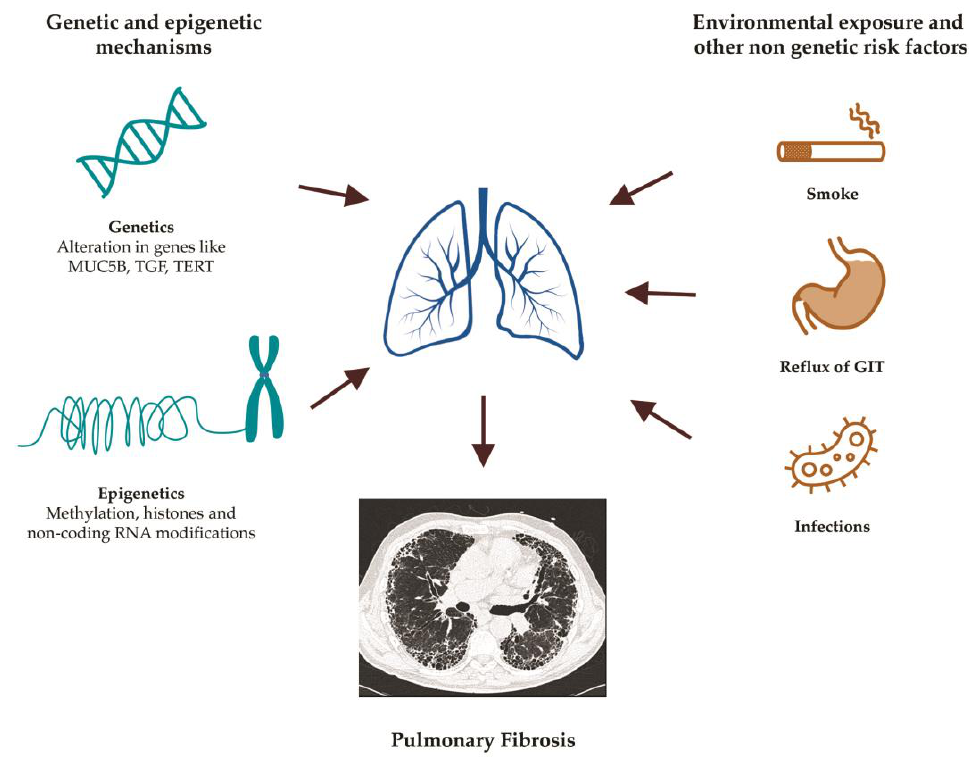
Figure 1. Main risk factors for the development of pulmonary fibrosis. Table 2. Genes described in idiopathic pulmonary fibrosis (IPF) and familial pulmonary fibrosis (FPF) and their profibrotic mechanisms.